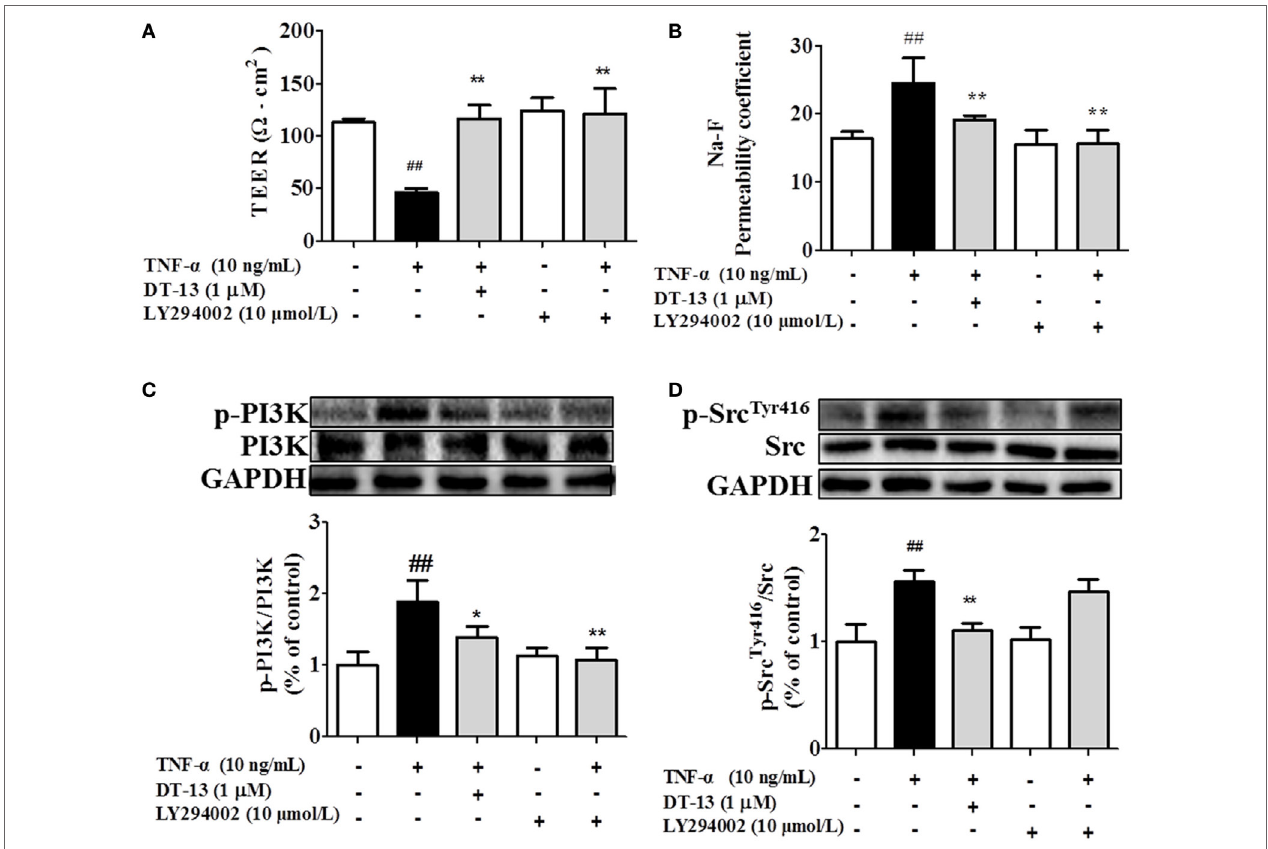
FigUre 5 | PI3K regulated TNF- α -induced permeability downstream of Src. Permeability was assessed by transendothelial electrical resistance (TEER) and permeability of sodium fluorescein (Na-F) across the human umbilical vein endothelial cell (HUVEC) monolayer. (a) TEER was significantly elevated in HUVECs pretreated with 10 µM LY294002. (B) Na-F permeability was significantly reduced in HUVECs pretreated with 10 µM LY294002. Western blotting analysis for the effect of DT-13 on (c) PI3K and (D) Src. Endothelial cells were pretreated with 10 µM LY294002 for 1 h before addition of 1 µM DT-13 for 1 h and then incubated with TNF- α for another 4 h for Western blot analysis. The data represent the mean ± SD from three experiments. ## P < 0.01 vs. the control group; * P < 0.05, ** P < 0.01 vs. the TNF- α